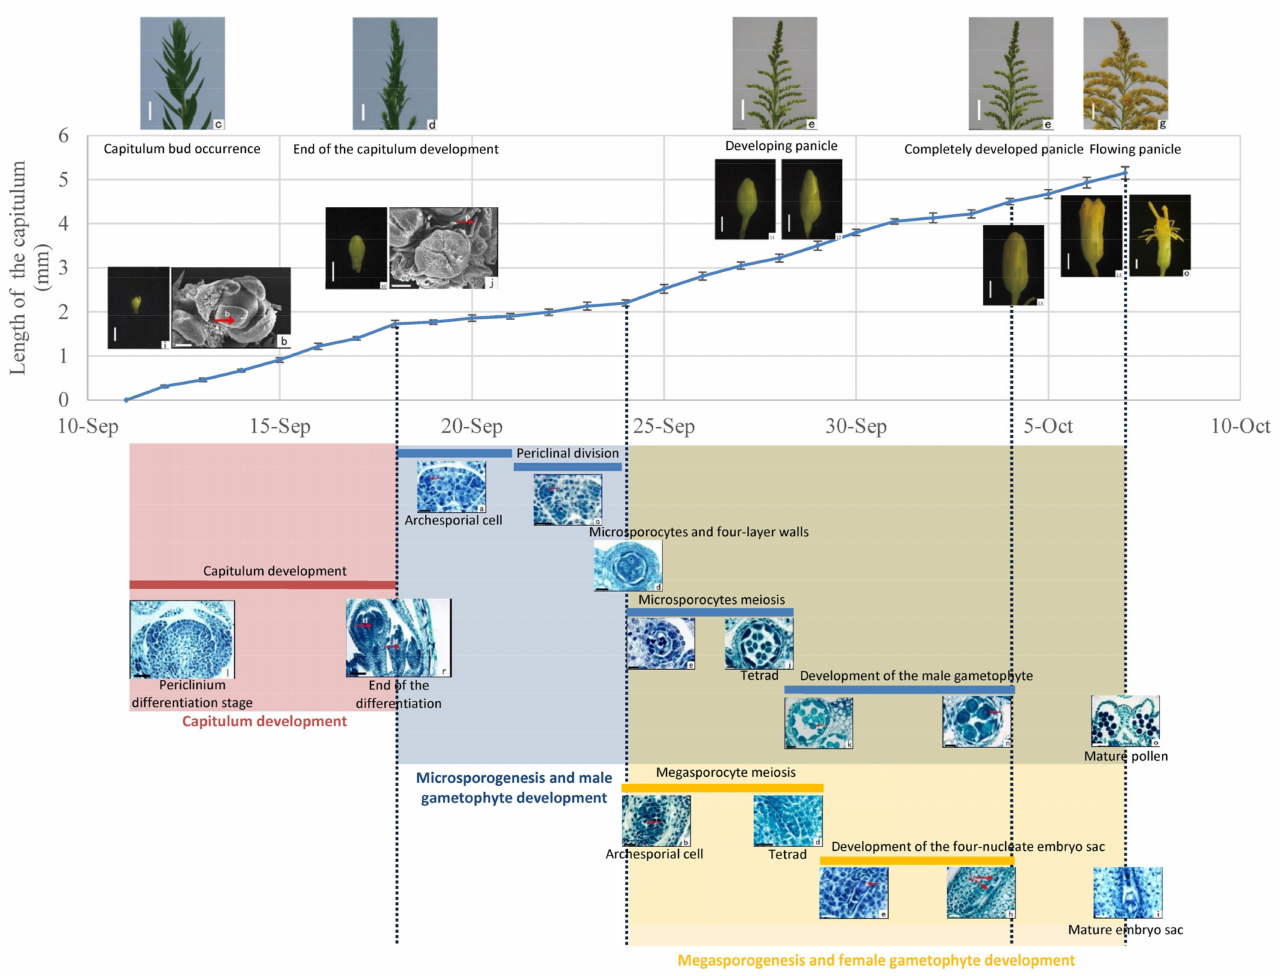
Figure 5. Reproductive calendar of S. canadensis (population number: CN04) representing the main developmental stages. Colored lines indicate the duration of the corresponding